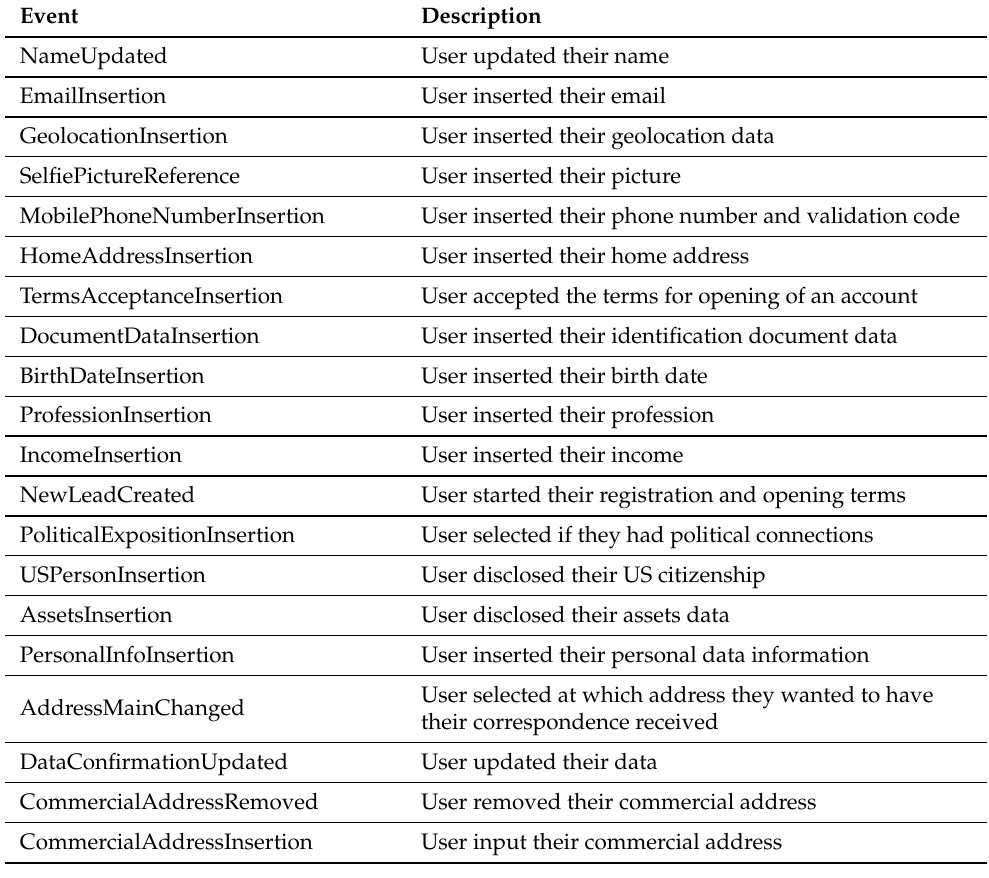
Table 1. List of events generated directly by a user’s